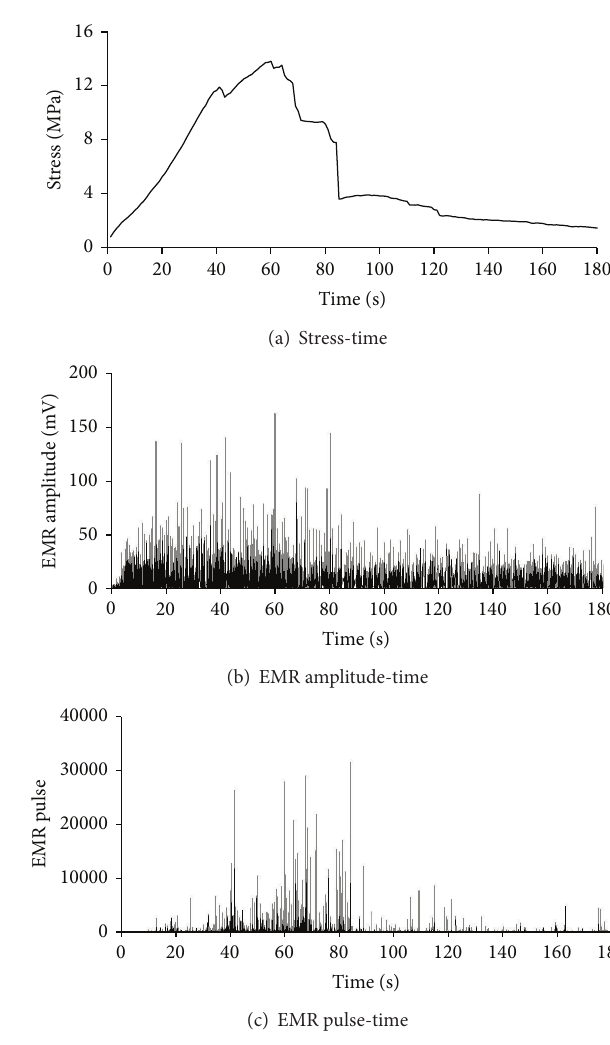
Figure 4: The measured stress and EMR of LM2# coal sample. Table 2: The measured maximum amplitudes of EMR. Sample label